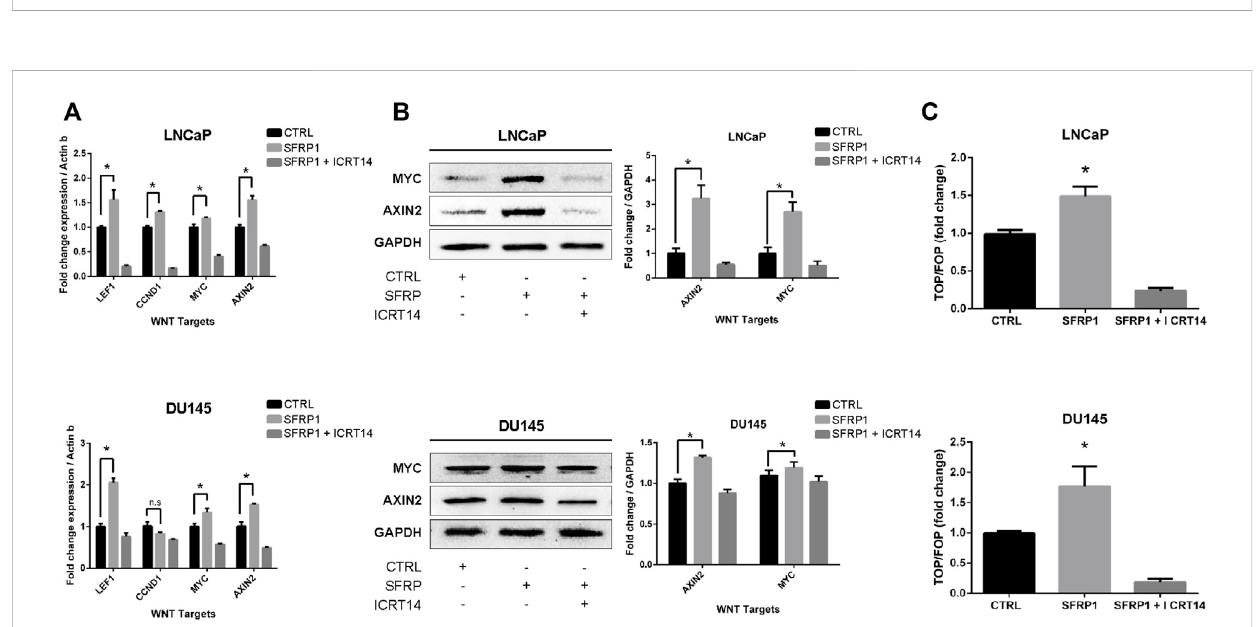
FIGURE 6 LNCaP and DU145 cell lines were treated with SFRP1; SFRP1 + ICRT14 or vehicle for 48 h. (A) The differential expression of WNT target genes was evaluated using qRT – PCR. Actin-b served as the normalization control. (B) Western blot was used to measure the protein levels of AXIN2 and MYC. The relative expression was quanti fi ed using ImageJ software and is displayed below the western blots (fold). (C) Luciferase reporter assay of ß -catenin-Tcf/ Lef activity was used. LNCaP and DU145 cells were transfected with the Wnt signalling reporter (TOP fl ash or the control FOP fl ash). It shows the TOP/FOP fold change relative to control (* p <